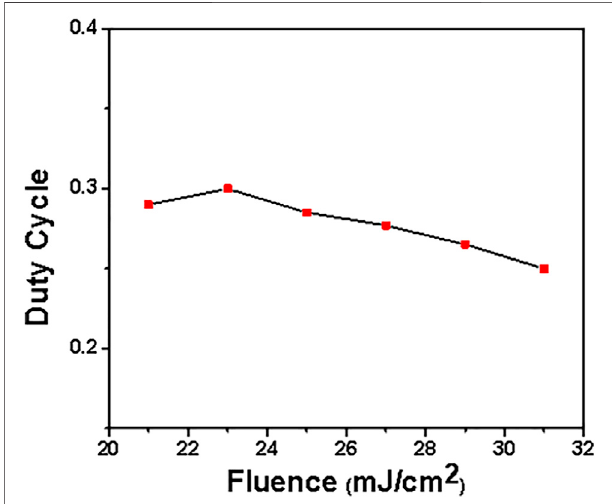
FIGURE 4 | Variation of duty cycle with laser fl